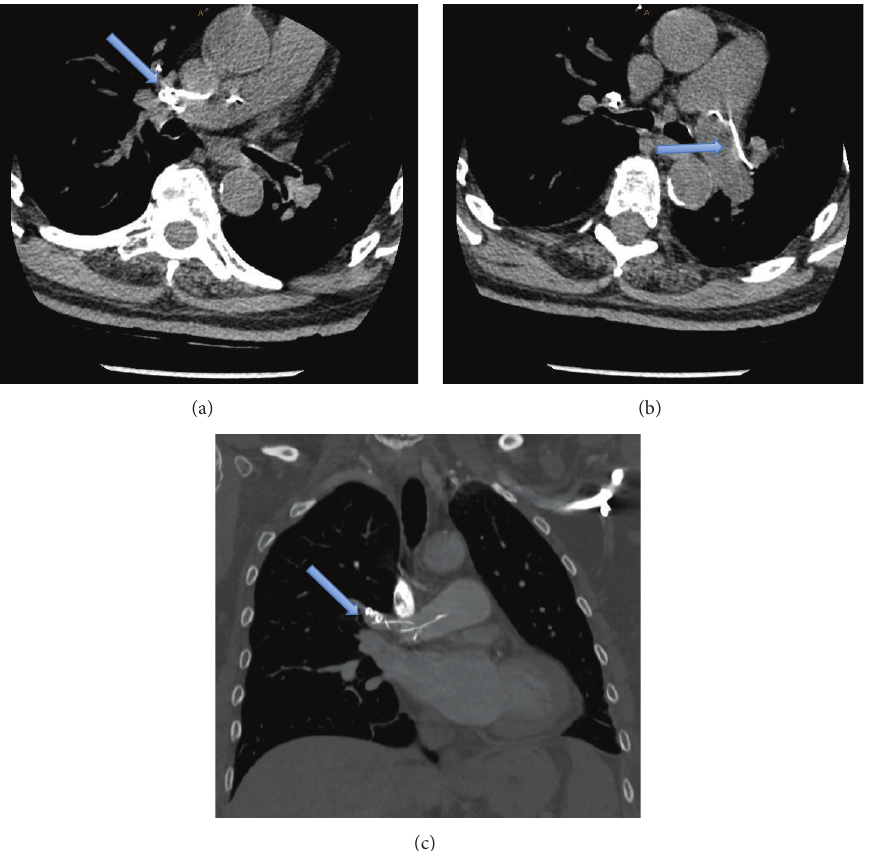
Figure 1: (a) An axial cut of the chest CT-scan of a nonenhanced CT chest showing multiple linear and extremely dense bone cement emboli involving pulmonary trunk and right pulmonary artery. (b) An axial cut of a nonenhanced CT chest showing a cement embolus involving the left main pulmonary artery. (c) A coronal cut of CT pulmonary angiogram also showing the cement emboli at the pulmonary trunk and right main pulmonary